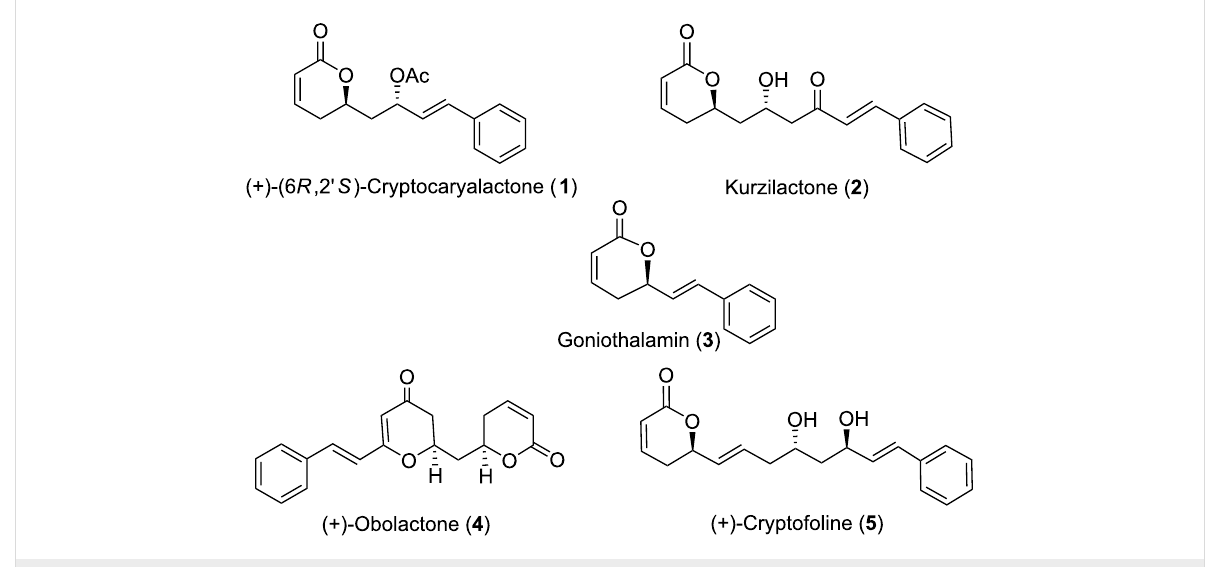
Figure 1: Some natural products containing styryl lactones.